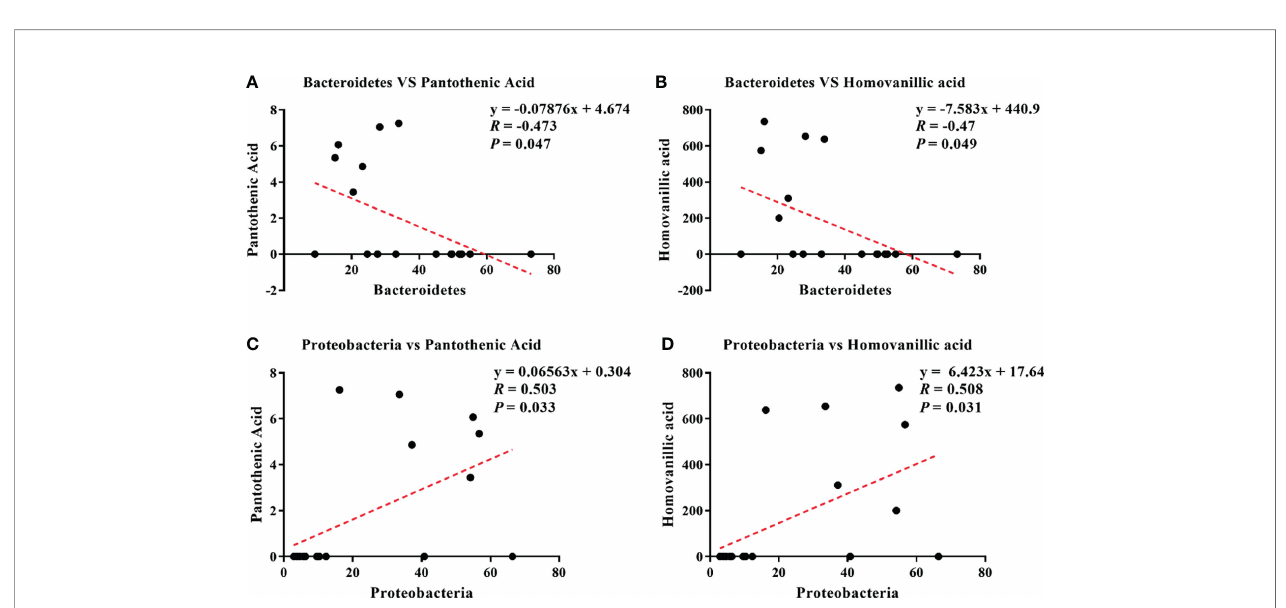
FIGURE 7 | Correlations between differential microbes and serum metabolites during the development of in fl ammation induced by LPS: Bacteroidetes – pantothenic acid (A) , Bacteroidetes – homovanillic acid (B) , Proteobacteria – pantothenic acid (C) , and Proteobacteria – homovanillic acid (D)